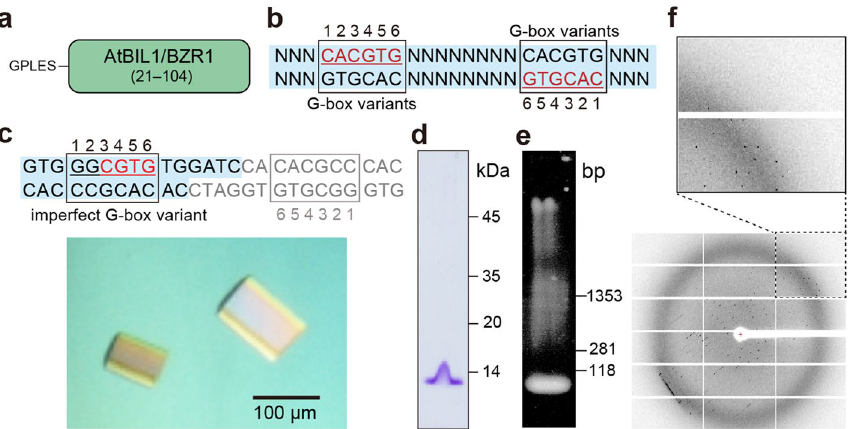
Figure 1. Crystallization and preliminary X-ray analysis of the unfused AtBIL1/BZR1 in complex with DNA. ( a ) Construction of the unfused AtBIL1/BZR1 used for crystallization. ( b ) DNA constructs successfully cocrystallized with unfused AtBIL1/BZR1. ( c ) Crystals of the unfused AtBIL1/BZR1 in complex with target DNA containing an imperfect G-box variant. The detailed sequence of the DNA is shown above the photograph. ( d , e ) SDS-PAGE analysis ( d ) and agarose gel electrophoresis analysis ( e ) of dissolved crystals. ( f ) X-ray diffraction image (3.0 Å at the edge) from a